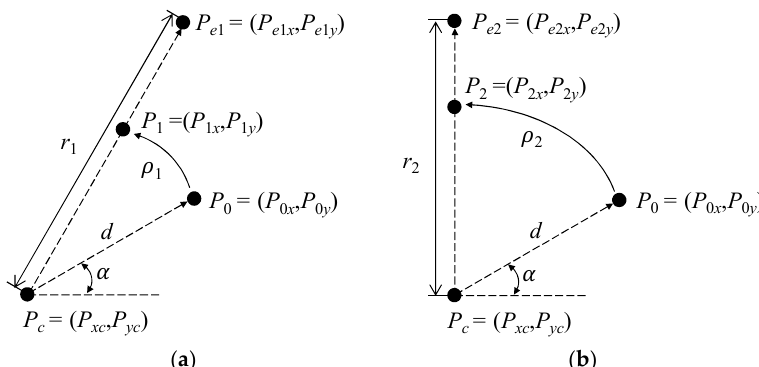
Figure 6. Schematic diagram of a point-cloud creation by an algorithmic approach. ( a ) First iteration; ( b ) Second iteration.